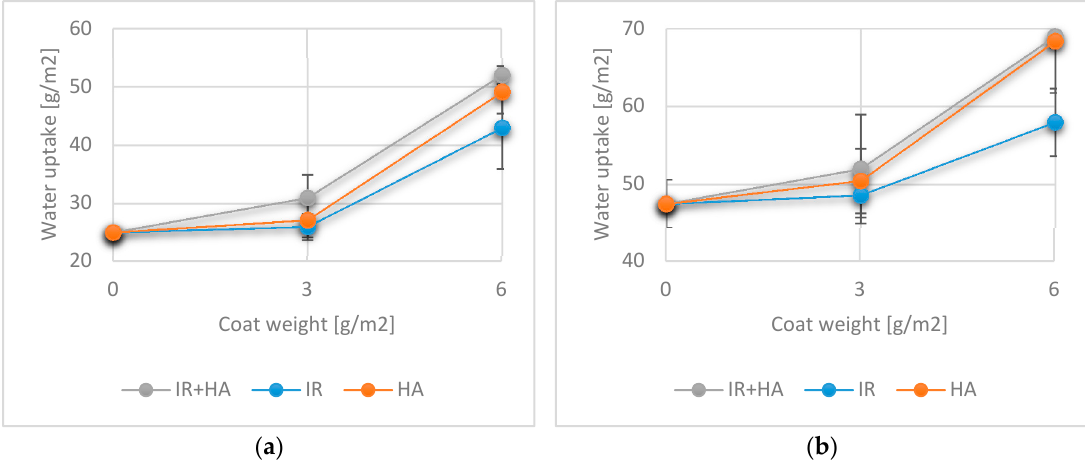
Figure 10. Cobb values for 60 s ( a ) and 1800 s ( b ) with uncoated samples and coated samples with one and two layers of chitosan. ( n = 8).